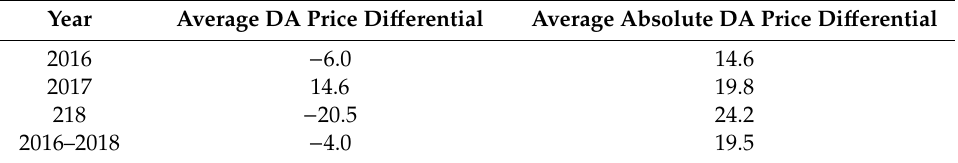
Table 2. Average and average absolute DA price di ff erential for the Bulgaria–Greece border.